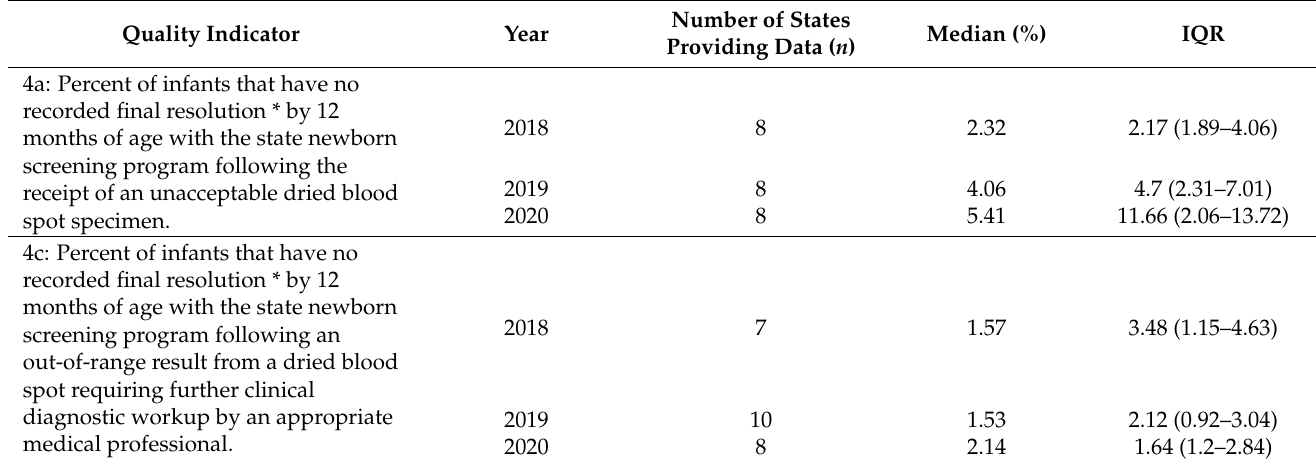
Table 3. Newborn screening follow-up Quality Indicator data